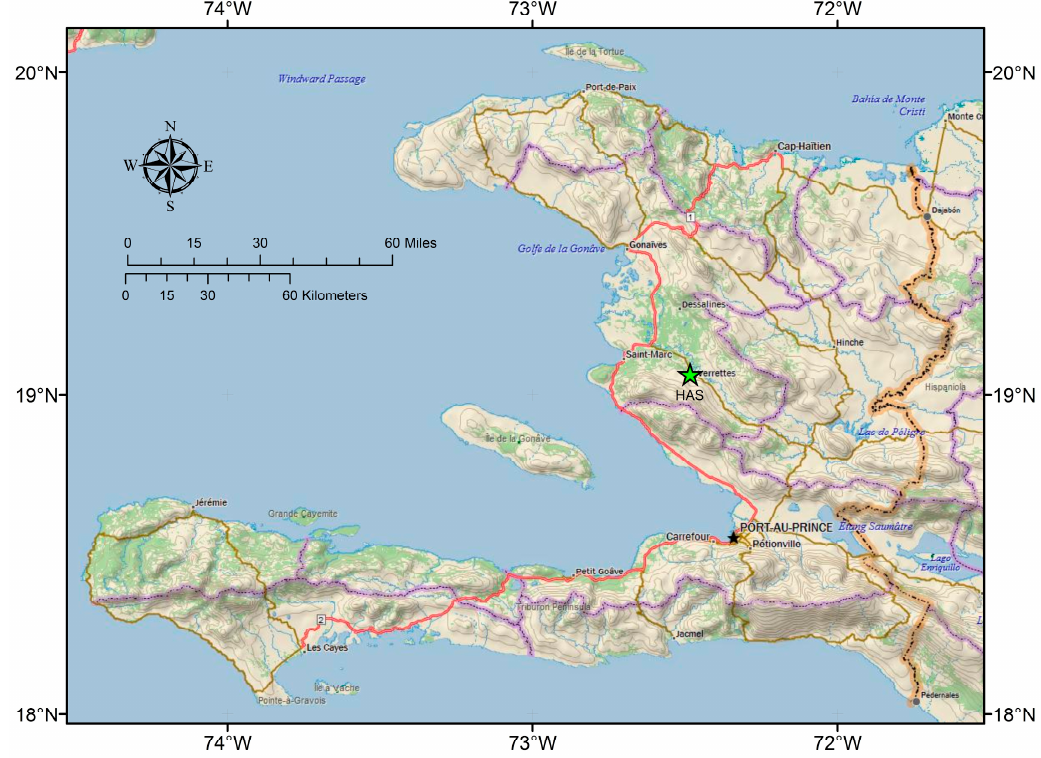
Figure 1. Haiti location map [3].